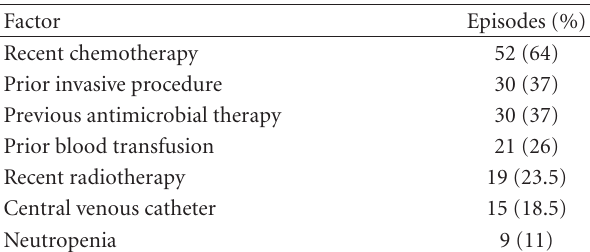
Table 2: Risk factors of the SSTIs episodes.